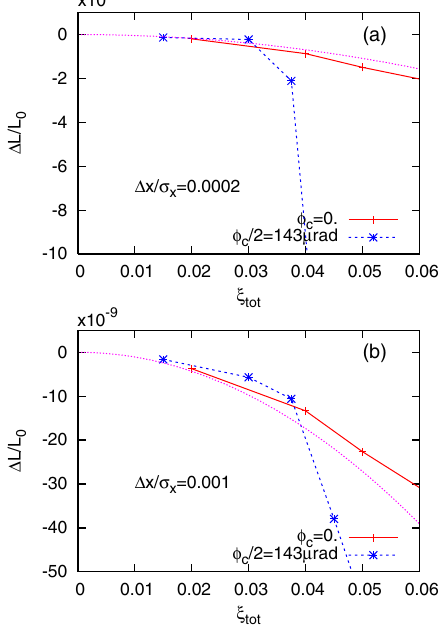
FIG. 22. Luminosity degradation as a function of the beam- beam parameter under an offset noise of two different amplitudes, with and without a crossing angle.